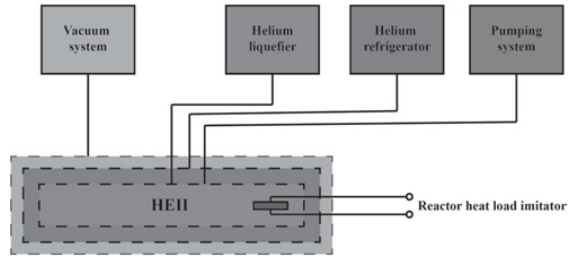
Figure 5. Schematic diagram of the technological equipment of the UCN source model.